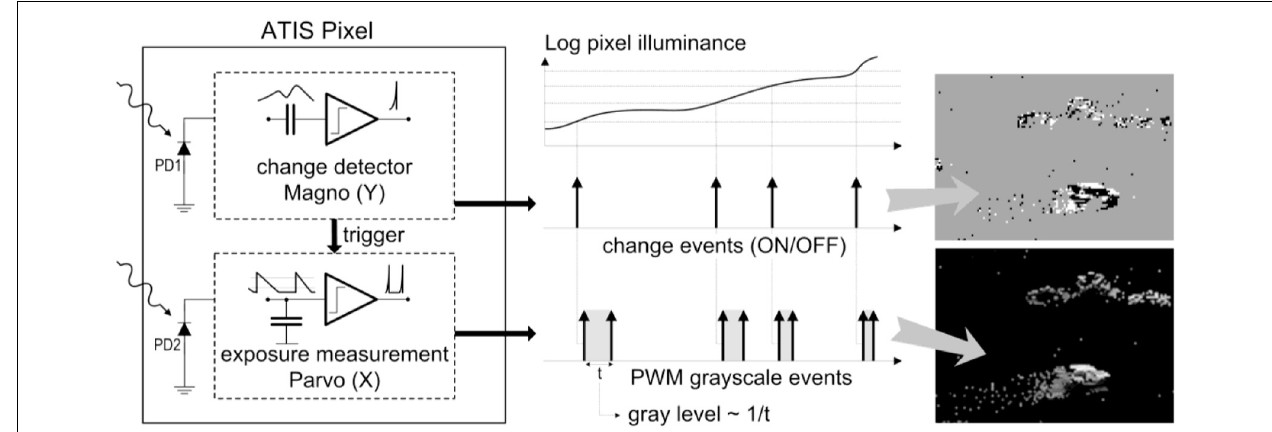
FIGURE 1 | Functional diagram of an ATIS pixel Posch (2010). Two types of asynchronous events, encoding change and brightness information, are generated and transmitted individually by each pixel in the imaging array.